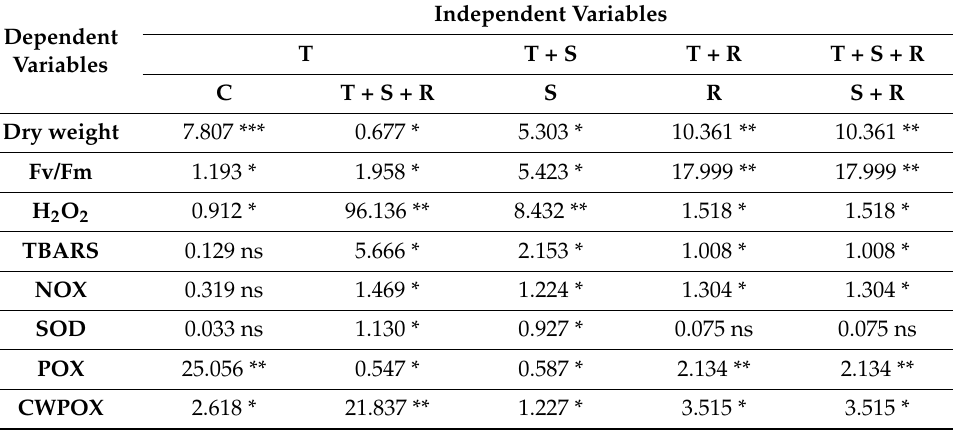
Table 1. Results of multiple comparisons by ANOVA for Trichoderma (T), Salt (S), Rhizoctonia (R), control (C) and their interactions for dry weight, Fv/Fm, H 2 O 2 , TBARS, NOX, SOD, POX, CWPOX values. Multivariate analysis through general linear model (GLM) was performed using the LDS